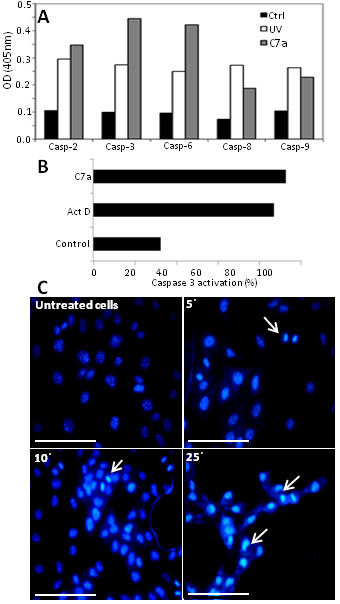
Caspase activation and nuclear alterations after treatment with C7a. (A) Activation of caspases after C7a treatment measured by a colorimetric assay. Ctrl, untreated tumor cells; UV, positive control, cells submitted to UV irradiation. (B) Percentage of activated caspase-3-positive cells in flow citometry after Actinomycin D or C7a treatment. Control, untreated tumor cells incubated with anti-active caspase 3 antibody. (C) Representative images of C7a-treated B16F10-Nex2 cells after nuclear staining with Hoescht 33342. Arrows represent nuclear alterations. Magnification, 400 ×, and scale bars, 20 μm. Results are representative of at least 2 independent experiments.